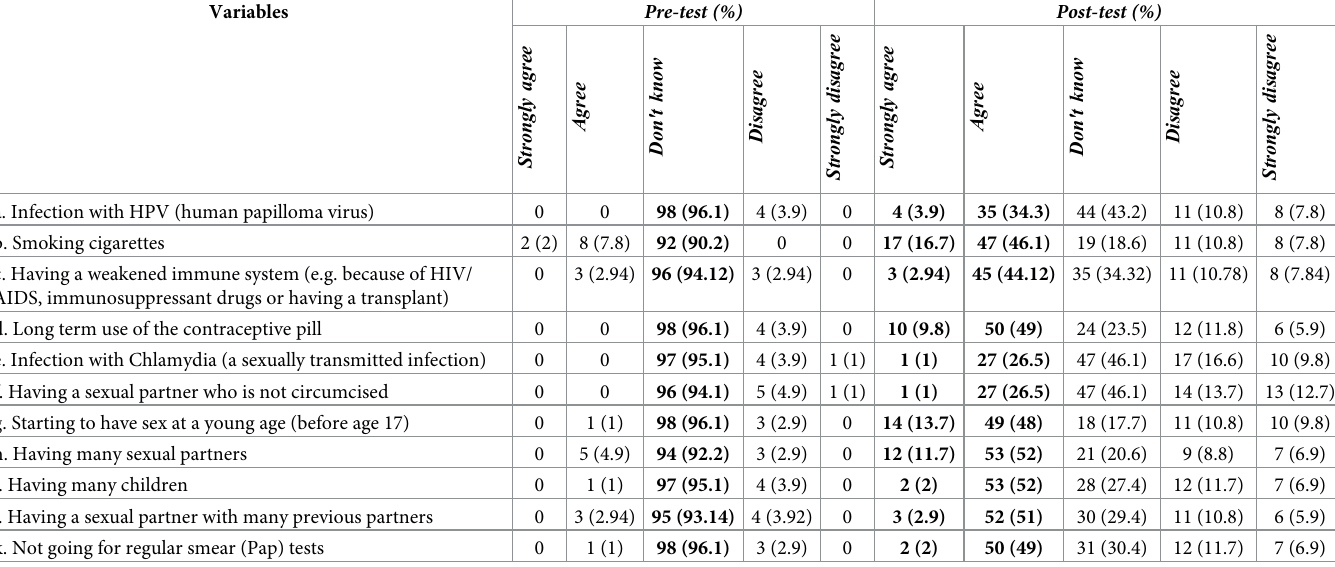
Table 2. Comparison of the pre-and post-test responses regarding knowledge on risk factors of cervical cancer (n = 102). Variables